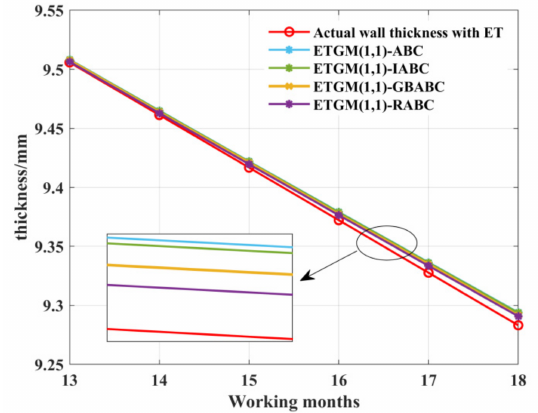
Figure 9. Prediction curve for wall thickness.